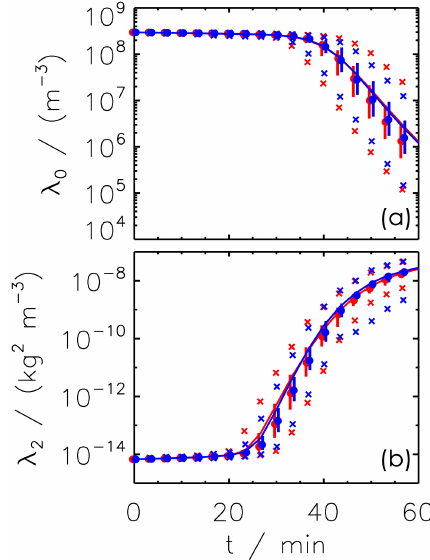
Figure 16. Moments λ 0 and λ 2 as a function of time obtained by AON for the Long kernel. Each realisation was initialised with a different SIP ensemble (probabilistic singleSIP, red) or all realisa- tions started with the same SIP ensemble (deterministic singleSIP, blue). In both cases, the curves show an average over 50 realisations with the vertical bars indicating the interquartile range. The crosses show the minimum and maximum values and the circle the median value. The parameter settings are (cid:49)t 20 and κ 40. = =